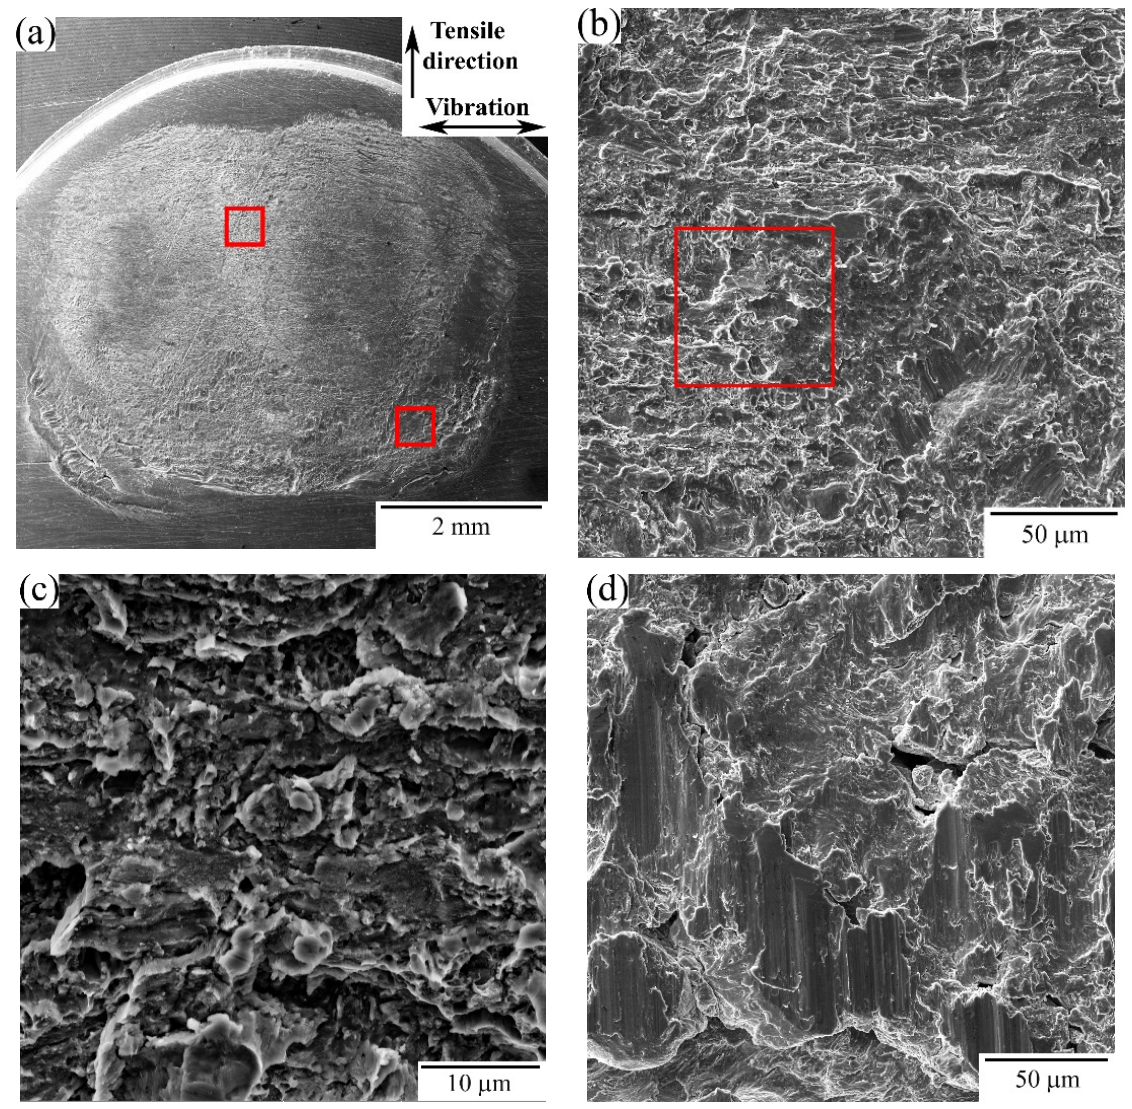
Figure 7. Typical SEM images of lap shear fracture surfaces joints of samples with initial UFG structure: an overall view ( a ), central zone of the fracture surface ( b ), higher-magnification view of the area in the rectangle in ( b , c ), and peripheral zone of the fracture surface ( d ).